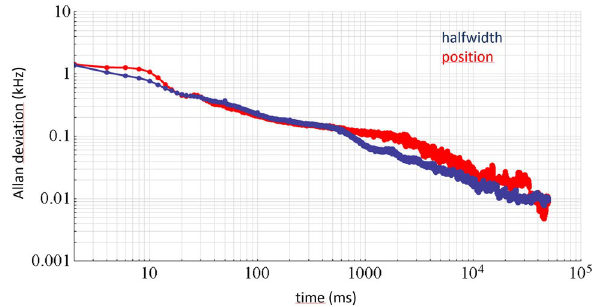
Figure 6. Allan deviations of fitted half widths and positions of cavity modes. The plotted Allan deviations of fitted halfwidth (blue) and position (red) is averaged over all 22 simultaneously measured modes in the coherently driven excitation approach. One set of cavity modes was obtained from an average of 20 Fourier spectra based on individual signals that were 100 µs in